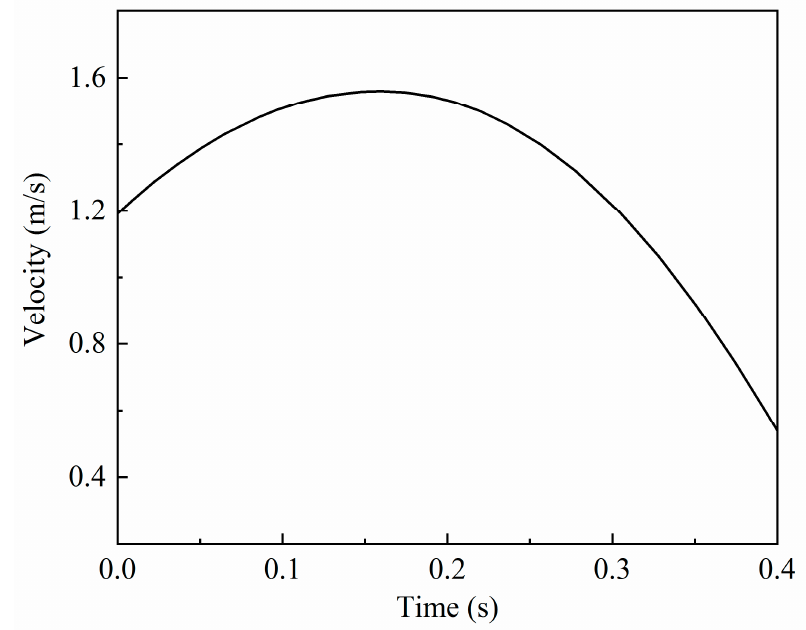
Figure 3. Several different bow-flared sections.